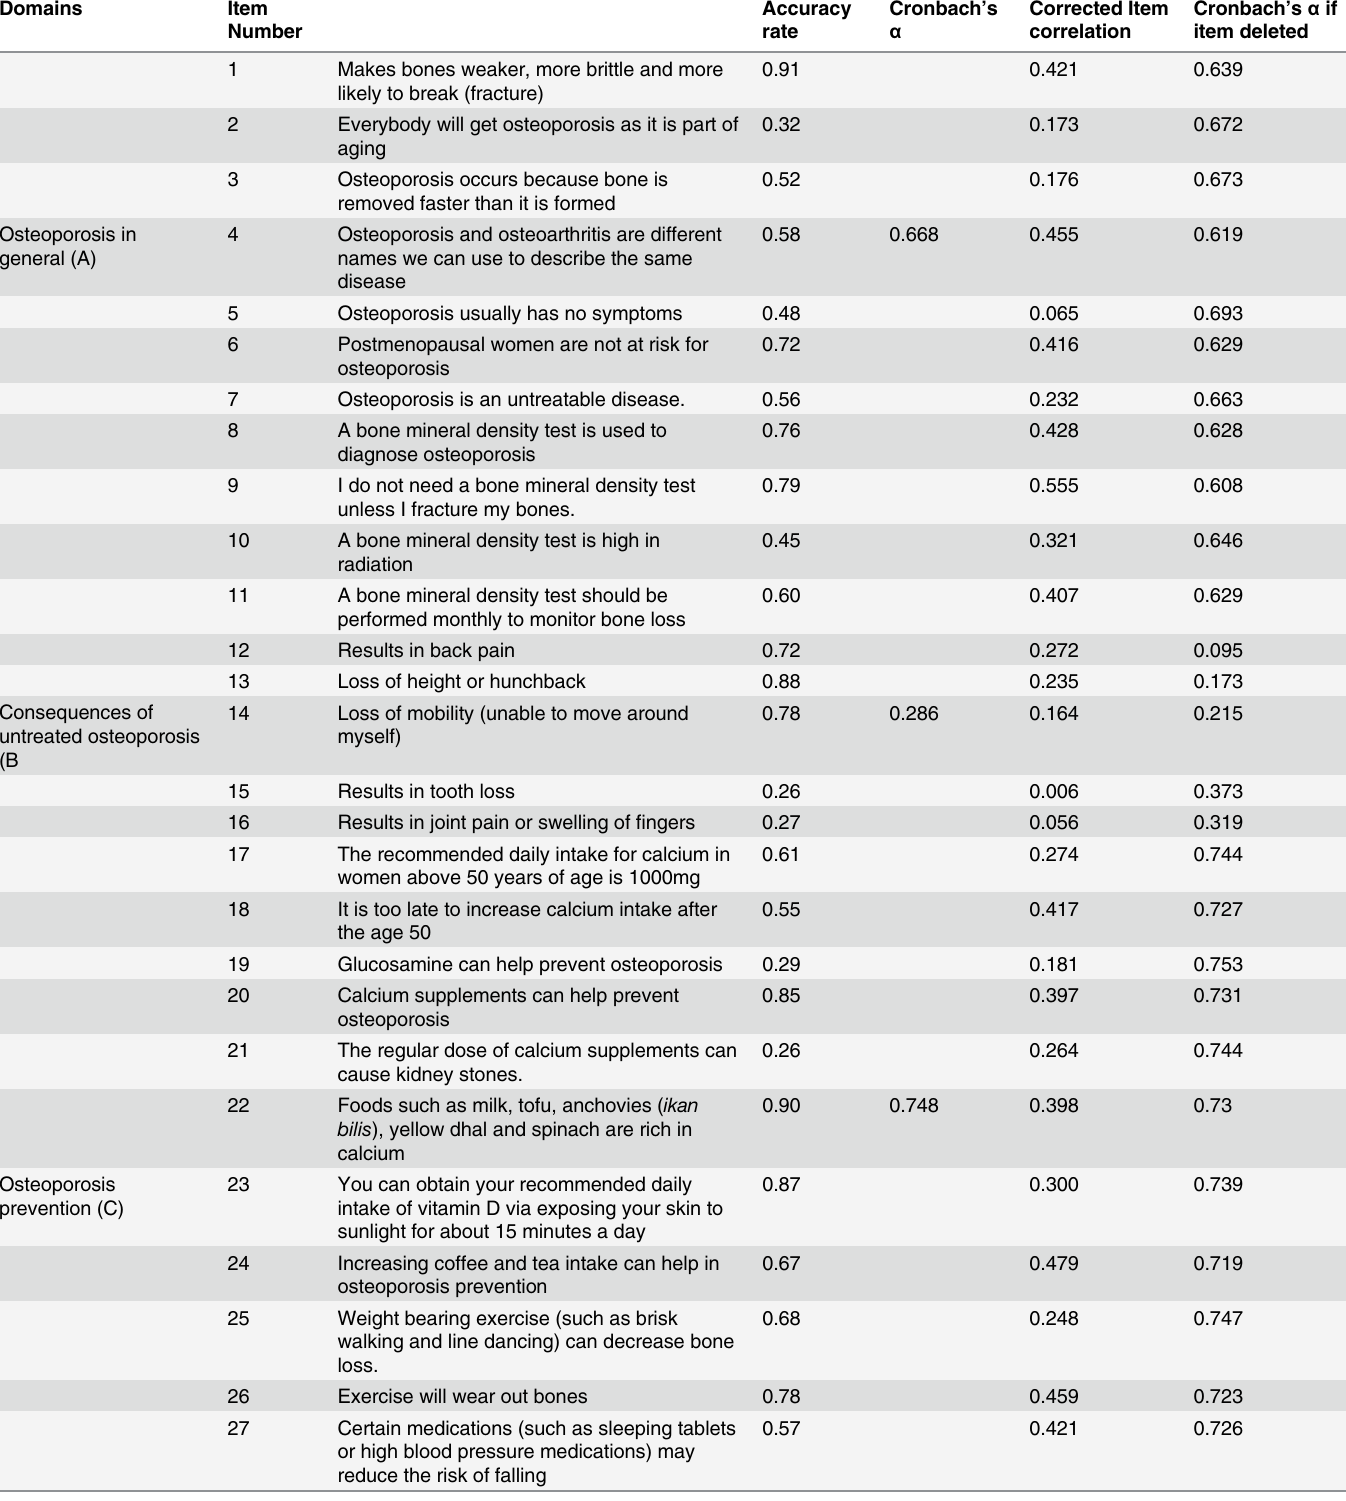
Table 8. Psychometric properties of the Osteoporosis Prevention And Awareness Tool (OPAAT).